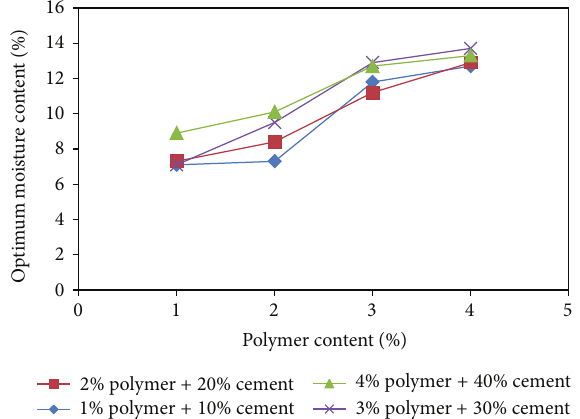
Figure 15: Effect of polymer content on OMC in wet conditions for 15 days.